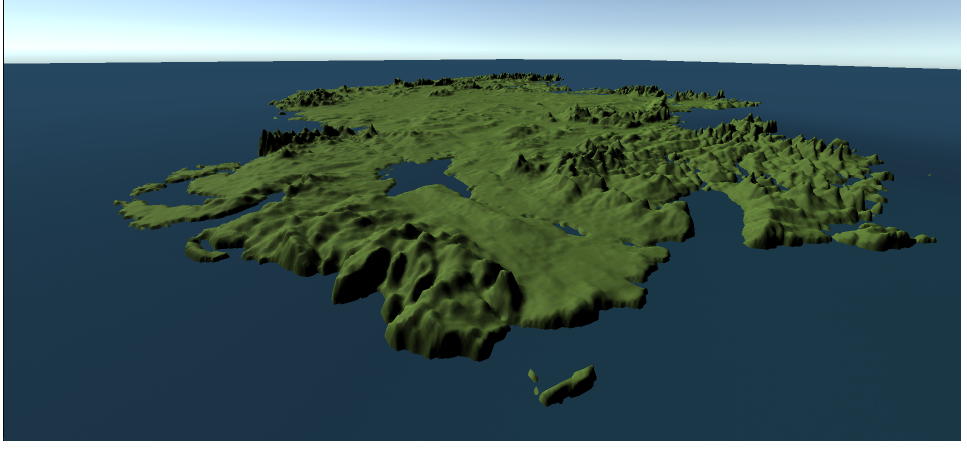
Figure 2. One of the sample environments to run the simulations on a medium-sized isolated island with a high land ratio, but plenty of water